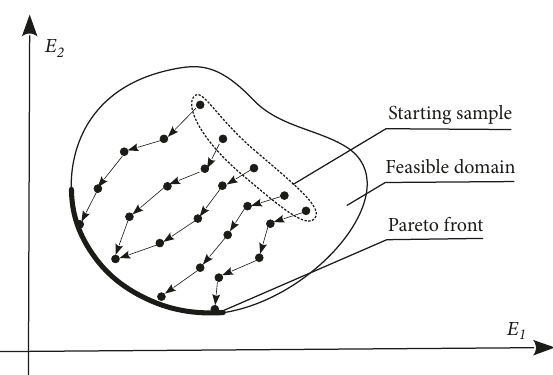
Figure 2: Hypothetical improvement pattern of parallel annealing chains in parallel PSA